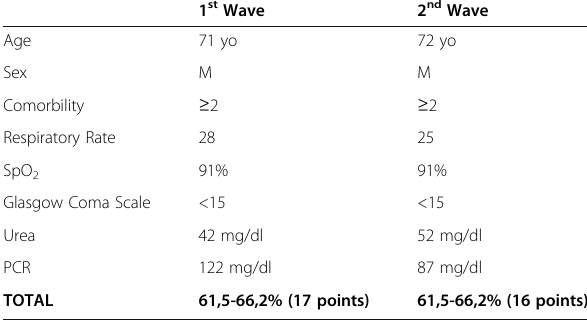
Table 1 (abstract A103). “ 4C mortality score ” calculation in the two waves